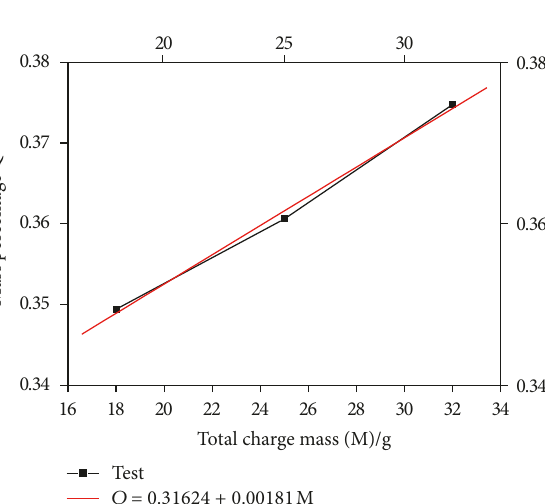
Figure12:Relationcurvebetweenmasspercentageandtotalcharge.